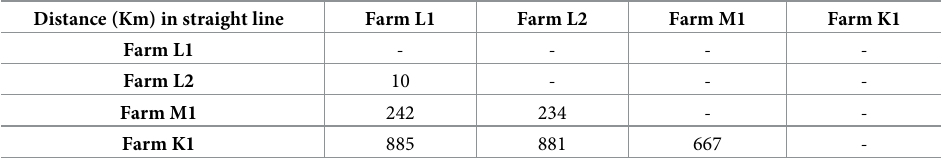
Table 2. Distance in straight line (Km) among the different sampling sites of Bathycoelia distincta population. Distance (Km) in straight line